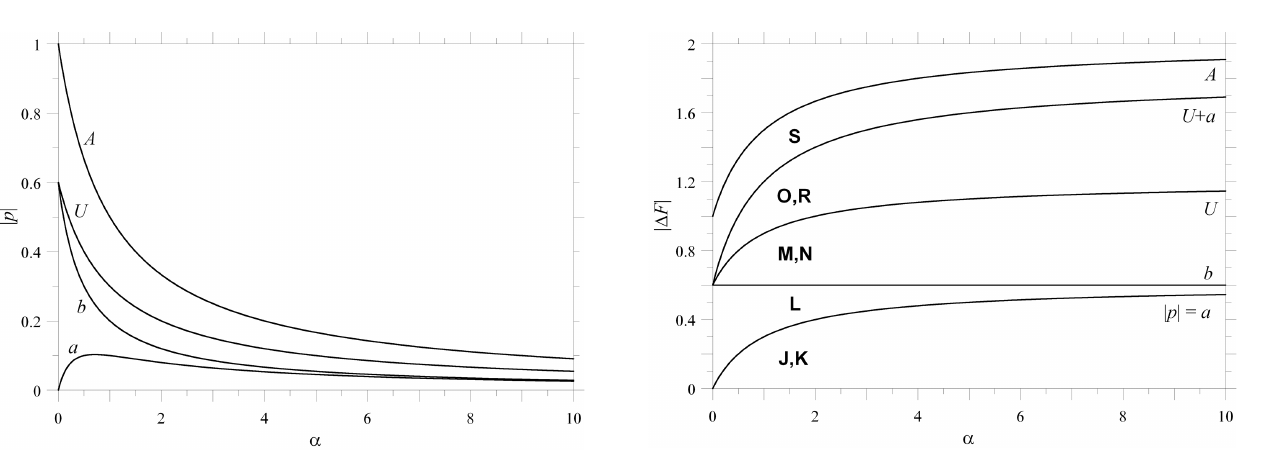
Fig. 5. The values a , b , U and A of | p | as functions of the coupling degree α ( (cid:15) = 0 . 7).